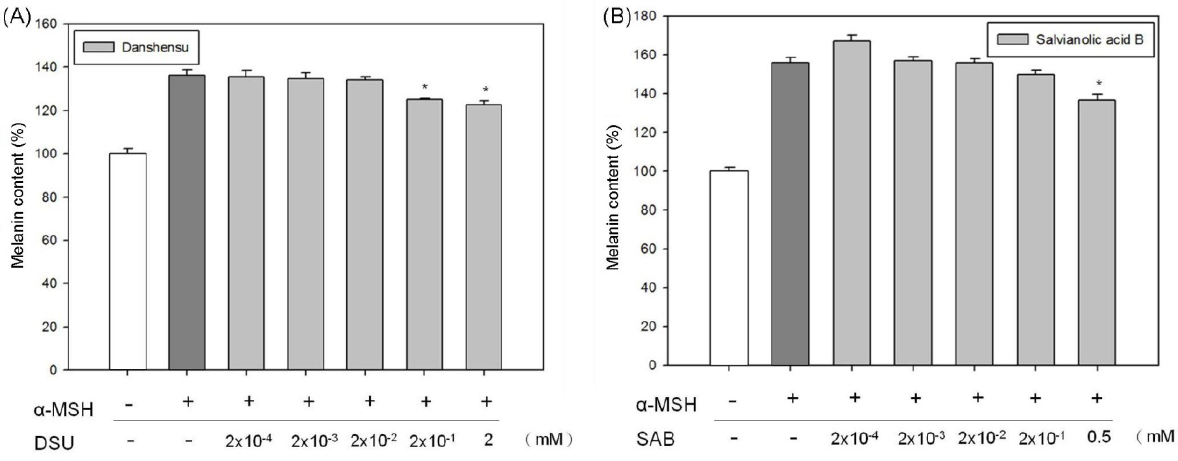
Figure 7. The inhibition effects of ( A ) danshensu (DSU) and ( B ) salvianolic acid B (SAB) on melanin production in α -MSH-stimulated B16 cells. Each value represents the mean ± SE ( n = 3). * p < 0.05, compared with the